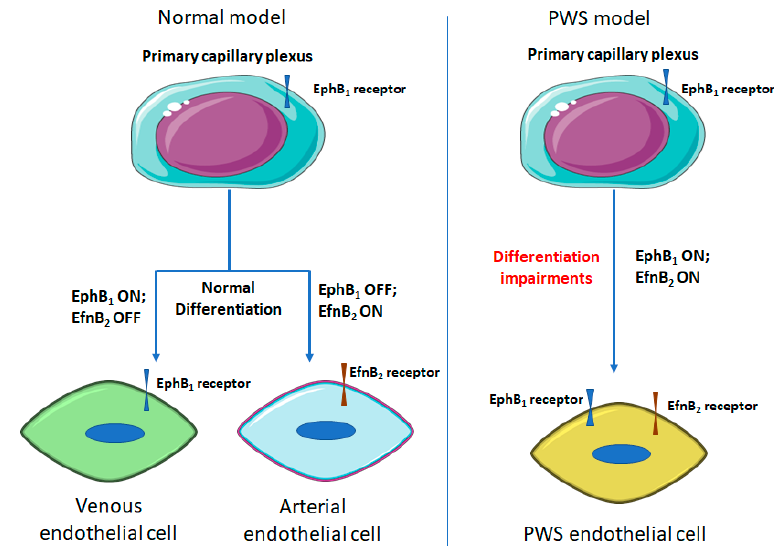
Figure 1. Role of EphB 1 /EfnB 2 in differentiation of endothelial cell from primary capillary plexus (PCP). EphB 1 is a biomarker for venous ECs, while EfnB2 is a biomarker for arterial EC. In normal development, mutually exclusive expression of EphB1 or EfnB2 determines dermal arterial or venous differentiation from PCP [43]. In PWS model, both EphB 1 and EfnB 2 are co-expressed in ECs, leading to blood vessels with both venous and arterial characteristics.